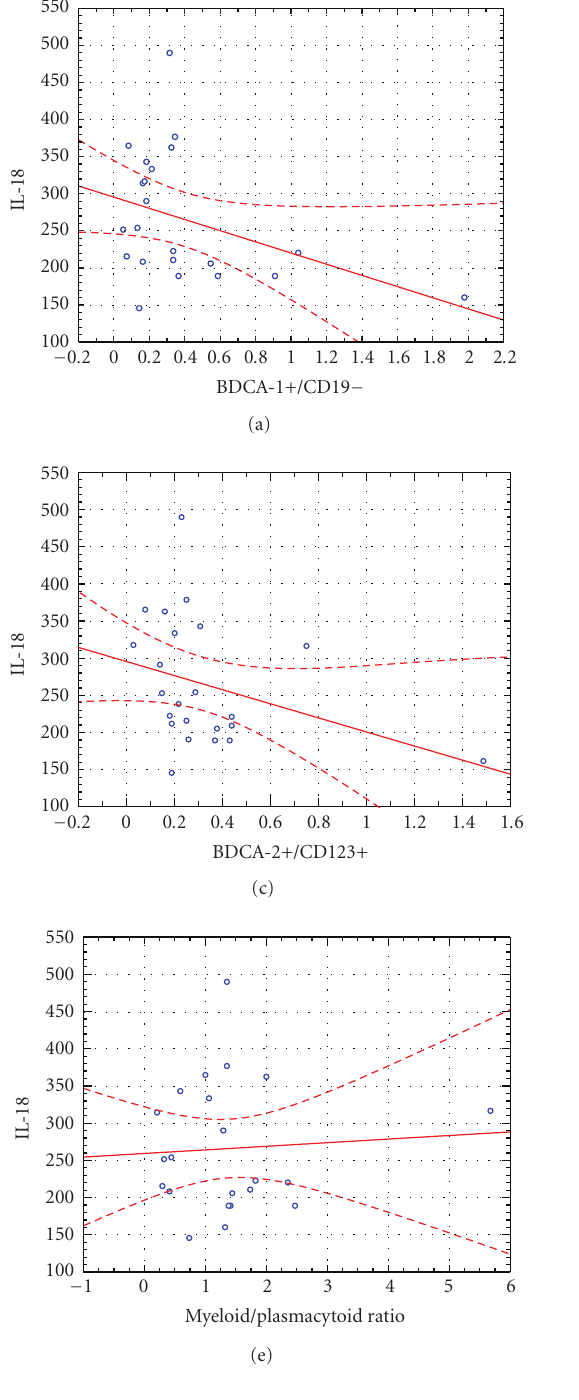
Figure 3: Correlations between IL-18 and DCs in patients with psoriasis and healthy